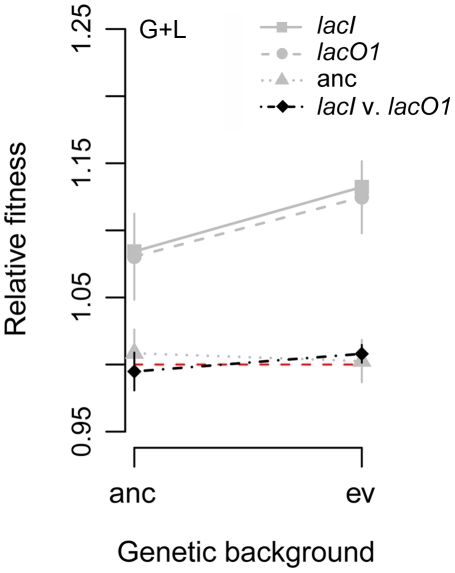
Fitness effect of lacI and lacO1 mutations depend on genetic background.The fitness effect of lacO1 and lacI mutations were measured in the ancestor and the G+L3-1 evolved genetic backgrounds when competed in the G+L environment. Gray points indicate fitness effect in competitions against the corresponding progenitor strains that do not have the added lac mutation; black points indicate fitness of lacI and lacO1 mutations competed directly against each other. Lines connect competitions of the same type but in different genetic backgrounds.